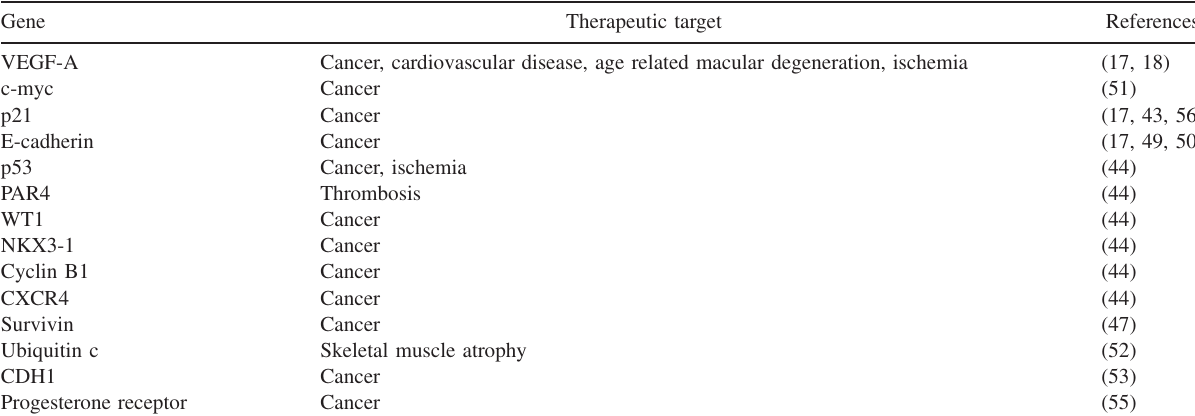
Table 1 Genes known to be regulated by small RNAs by an epigenetic mechanism and their possible therapeutic targets. Gene Therapeutic